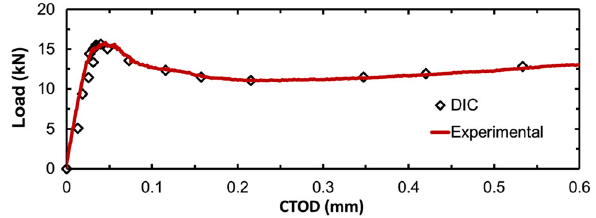
Fig. 9 Comparison of CTOD DIC and CTOD measured using surface mounted clip